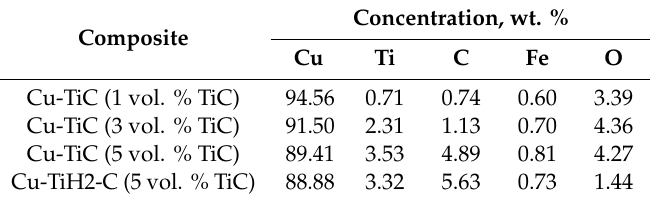
Table 1. EDS analysis of the as-milled composite powders.